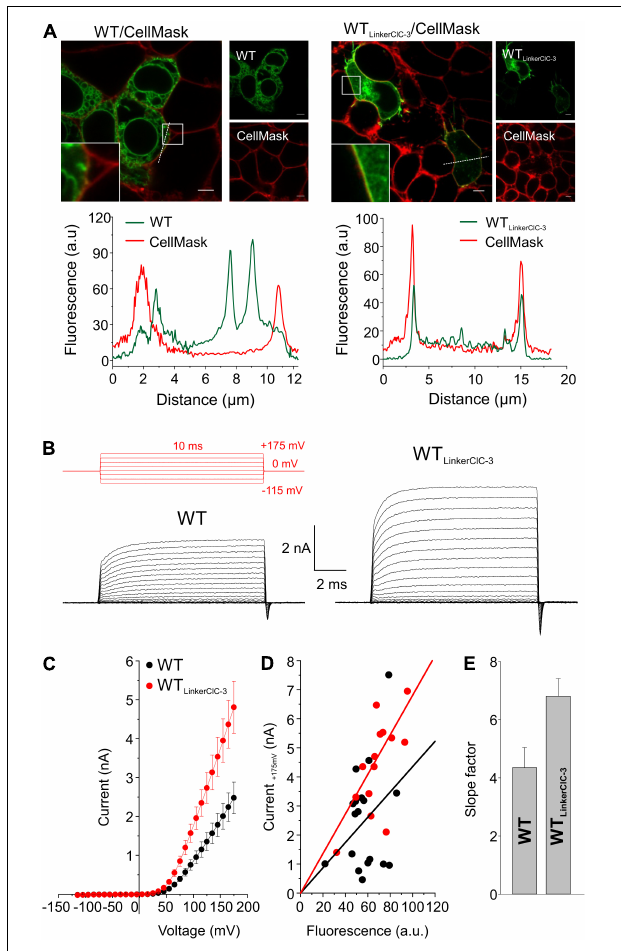
FIGURE 4 | Exchanging the ClC-4 linker region increases ClC-4 surface membrane insertion without affecting ion transport. (A) Representative confocal pictures of HEK293T cells co-expressing WT or WT ClC-4 LinkerClC − 3 together with the plasma membrane marker CellMask and line scan analyses illustrating that subcellular distribution pattern at both channels (dashed lines). Inset shows areas outlined in the white boxes. Scale bars 5 µ m. (B) Test pulse protocol (in red) and representative whole-cell recordings from HEK293T cells expressing WT or WT ClC-4 LinkerClC − 3 . (C) Steady-state current–voltage relationships for WT and WT ClC-4 LinkerClC − 3 , given as means ± s.e.m. (D) Current-fluorescence plots for WT and WT ClC-4 LinkerClC − 3 . Solid lines represent linear fits, (a.u. denotes arbitrary units). (E) Slope factors obtained from (D) . (WT, n = 18 and WT ClC-4 LinkerClC − 3 , n = 15) Data were obtained from four or five independent transfections.